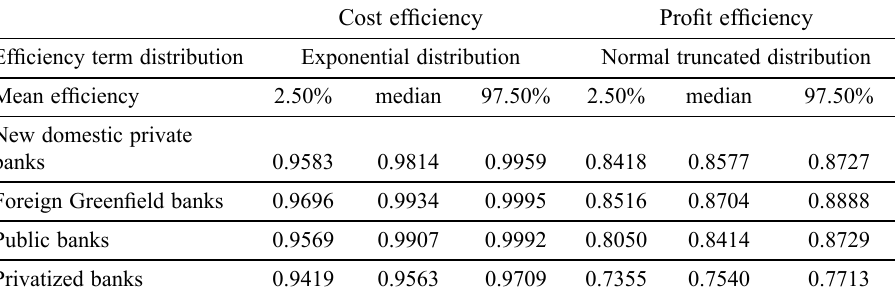
Table 8. Estimated mean bank efficiency according to its type of ownership without distinguishing presence/absence of a strategic foreign